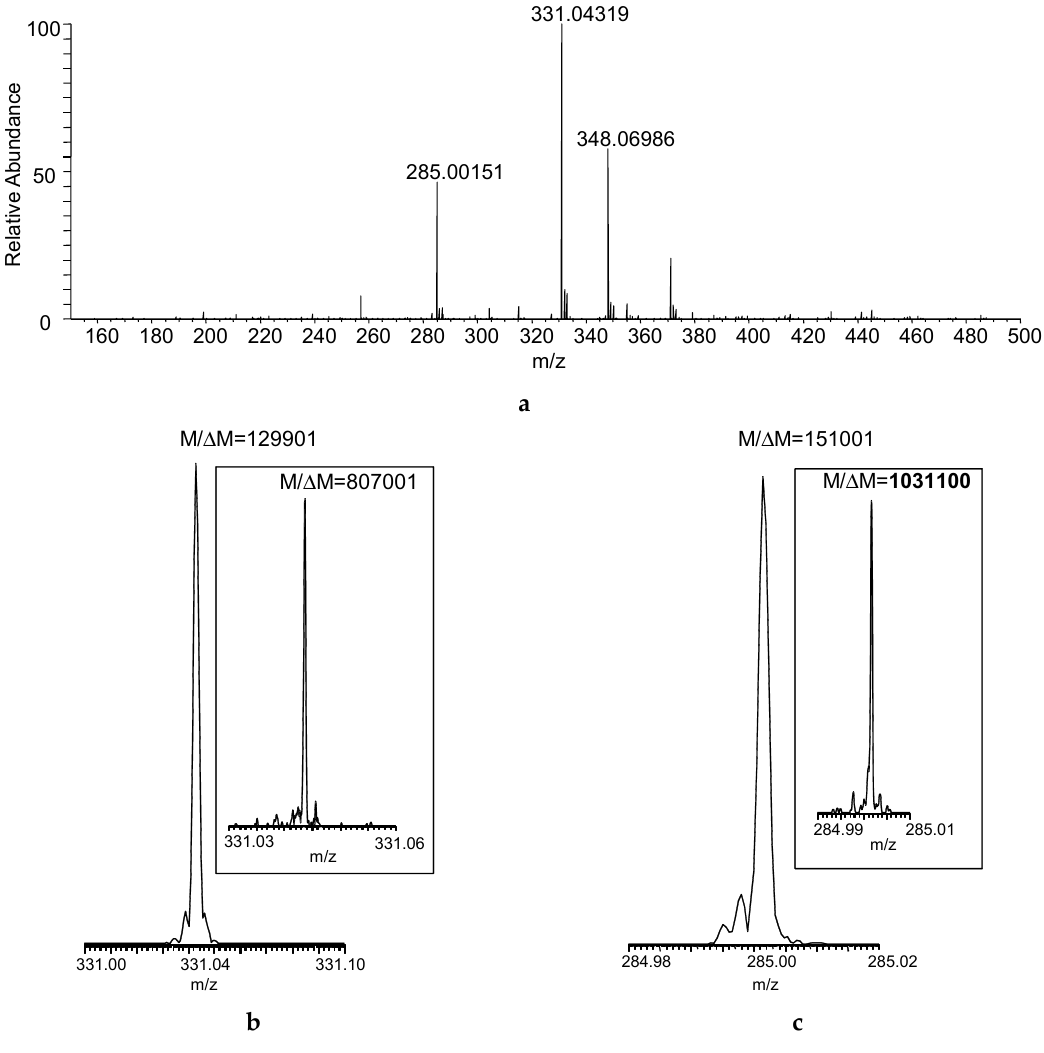
Figure 2. ( a ) Direct analysis in real time (DART) mass spectrum of a sample collected by swabbing from the field (Figure 1) using FT-ICR with desired M / Δ M set to 100,000 FWHM at m/z 400 (Mass spectrum averaged for the entire acquisition period); actual M / Δ M (FWHM) achieved for ( b ) the protonated malathion (nominal m/z 331) and ( c ) DART fragment ion of the compound (nominal m/z 285) at set mass resolution of 100,000 at m/z 400 (The insets show the actual M / Δ M with desired mass resolution set to 500,000 at m/z 400).